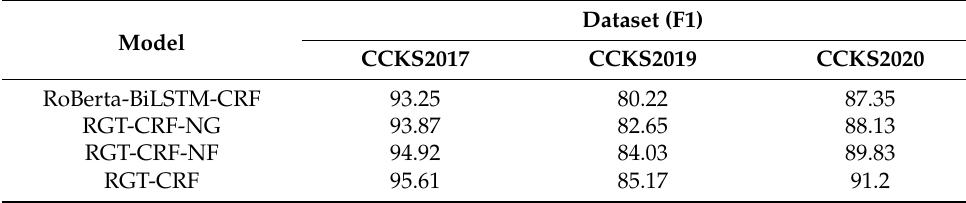
Table 8. Performance of different variants on three